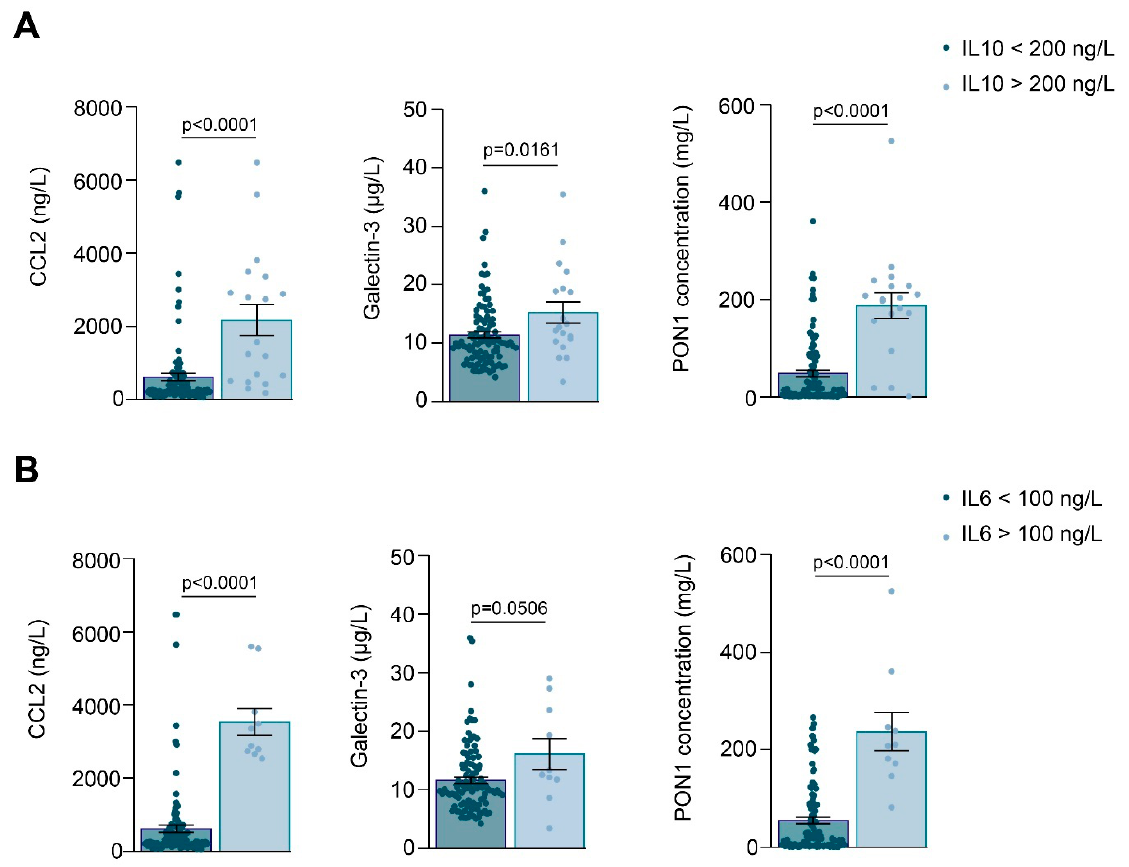
Figure 3. Interleukin (IL)-10 ( A ) and IL-6 ( B ) concentrations are associated with CCL2, galectin-3, and PON1 concentrations in COVID-19 positive patients. The figure shows scatter plots with error bars of selected variables segregated according to IL-10 and IL-6 concentrations. Results are given as means and standard error of the mean (SEM). Statistical analyses were performed using the Mann-Whitney U test. Table 2. Selected clinical variables in COVID-19 positive patients.